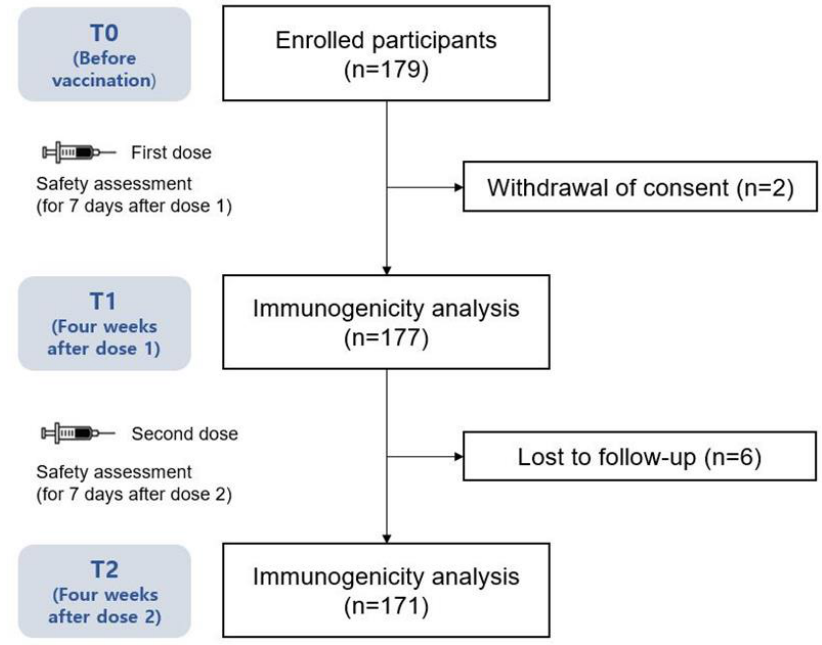
Figure 1. Study diagram. Table 1. Baseline characteristics and solicited adverse events after each vaccine dose.